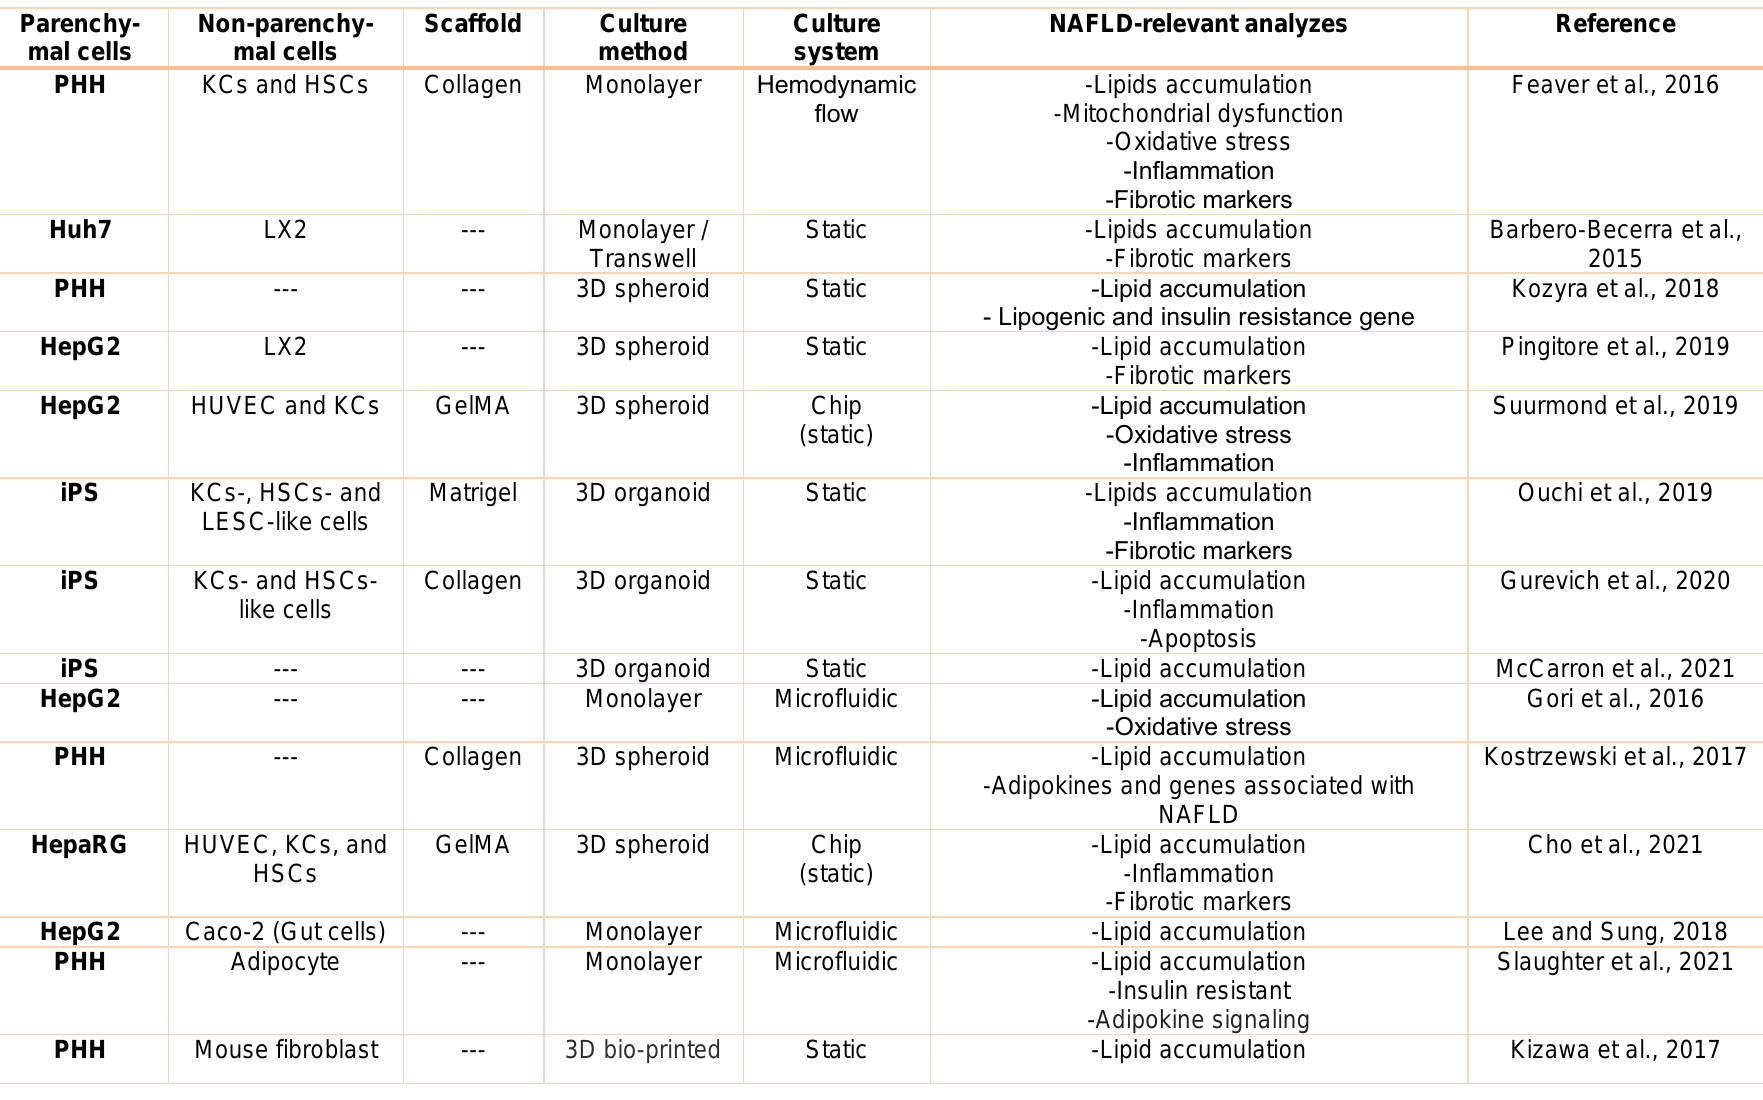
Table 1: Overview of human in vitro NAFLD Model